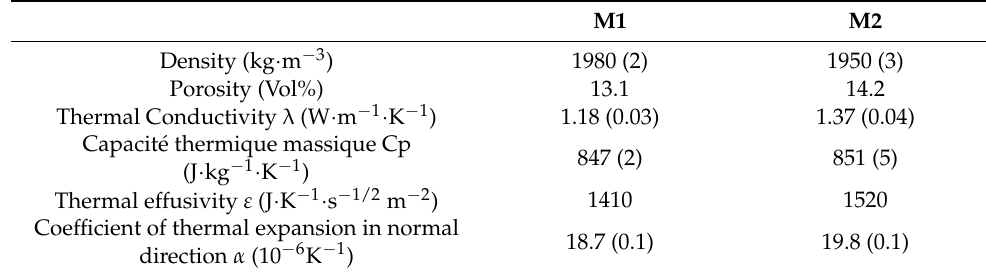
Table 3. Thermo-physical properties of M1 and M2.